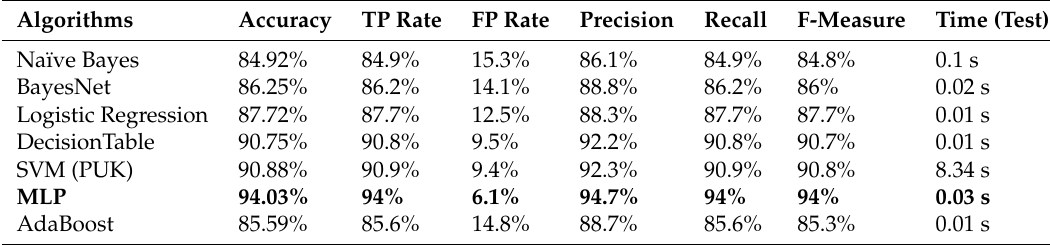
Table 13. Performance evaluation for 33-bus